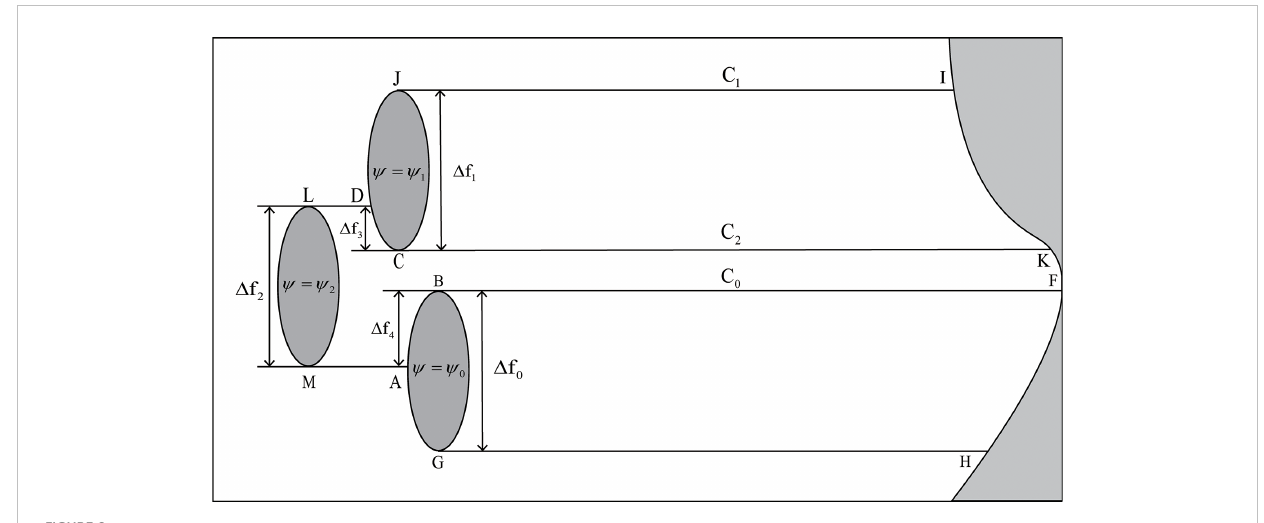
FIGURE 2 Map of islands and path of integration in Case